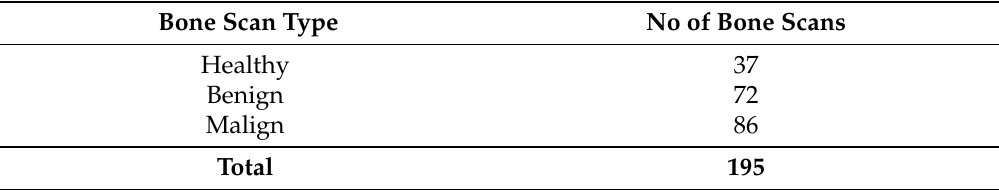
Table 1. Database summary. The database consists of a total of 195 bone scans divided into one of three categories: healthy, if no suspicious bone uptakes were detected, benign if bone hotspots with benign origins are present, or malign, if the images have bone metastases.